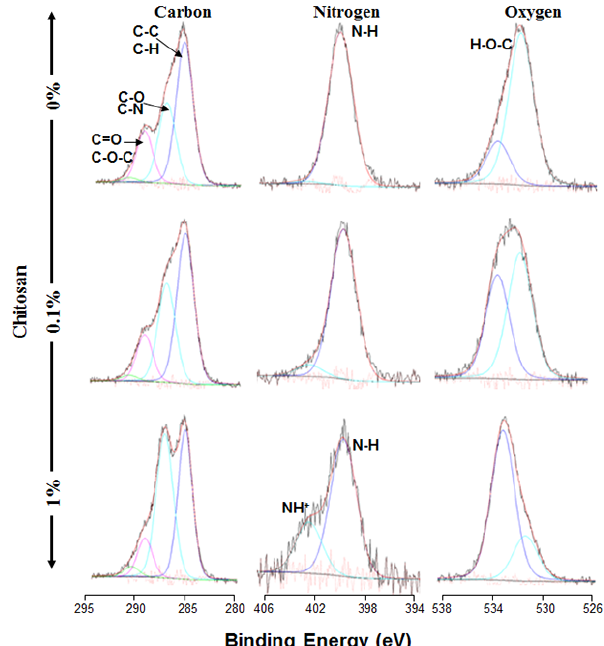
Figure 3. X-ray photoelectron spectroscopy (XPS) spectra of chitosan-coated collagen membranes. Materials with or without chitosan at various concentrations were synthesized and subjected to XPS analyses. Chemical composition spectra of the chitosan-coated and non-coated collagen membranes were compared ( n = 4).